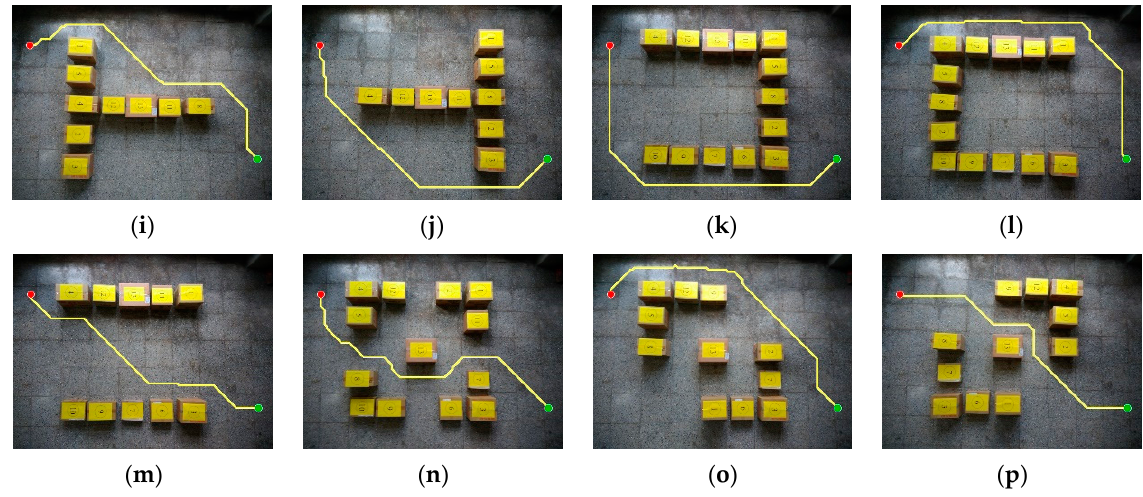
Figure 22. Planned paths shown in Experiment III: ( a ) result #1; ( b ) result #2; ( c ) result #3; ( d ) result #4; ( e ) result #5; ( f ) result #6; ( g ) result #7; ( h ) result t #8; ( i ) result #9; ( j ) result #10; ( k ) result #11; ( l )